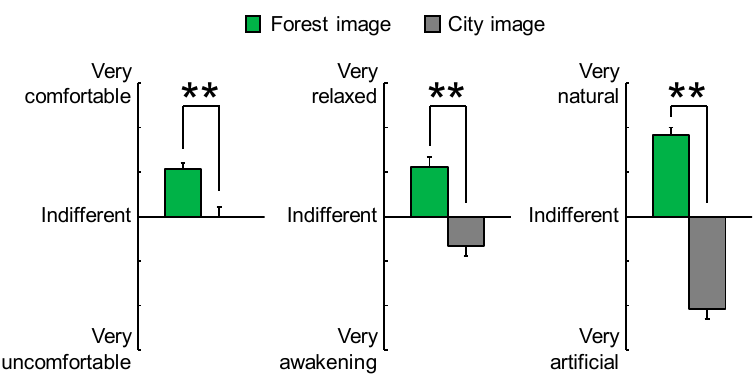
Figure 6. Subjective feelings measured with the modified semantic differential method after viewing forest and city images. Data are expressed as means ± standard errors, n = 17, ** p < 0.01 as determined by the Wilcoxon signed-rank test.